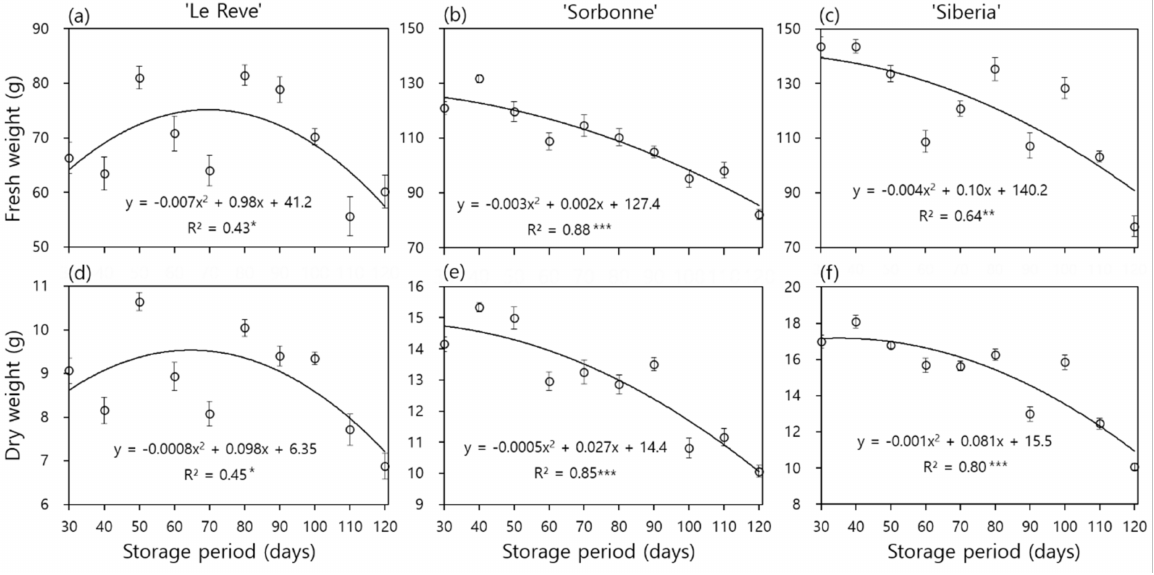
Figure 4. Fresh and dry weights of cut flowers as influenced by bulb storage period at 0 ◦ C in Lilium Oriental Hybrids ‘Le Reve’ ( a , d ), ‘Sorbonne’ ( b , e ) and ‘Siberia’ ( c , f ). *, **, *** Significant at p < 0.05, 0.01, or 0.001,